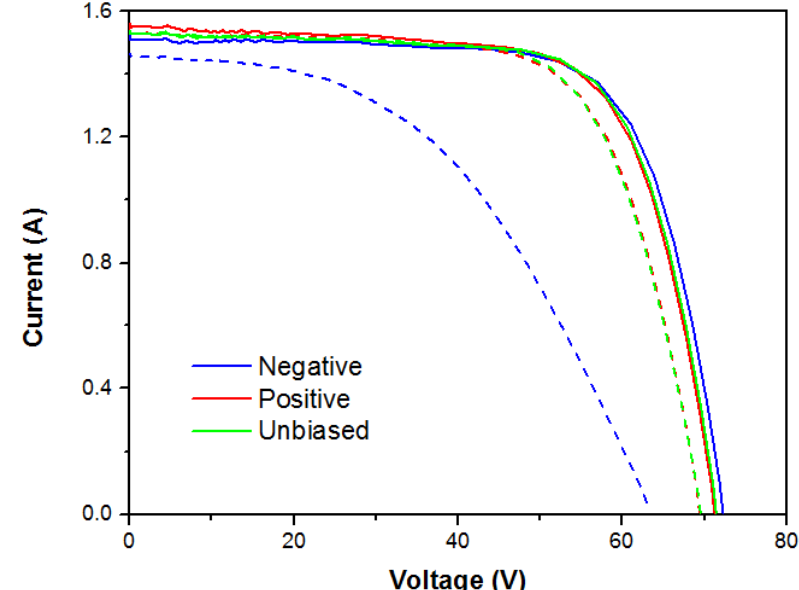
Figure 6. I - V curves of the three modules before (solid lines) and after (dotted lines) the tests in chamber.